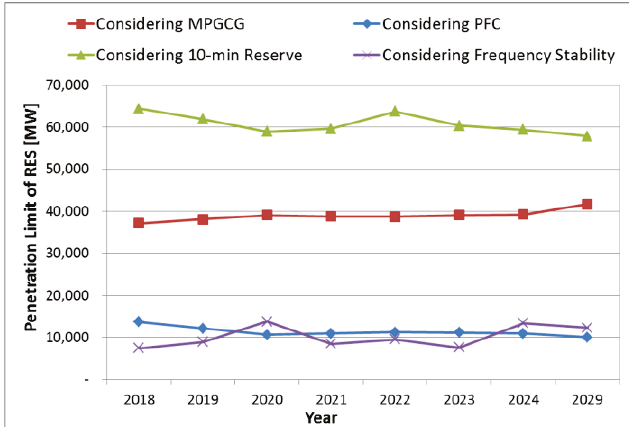
Figure 10. Comparison of the penetration limits of RES.